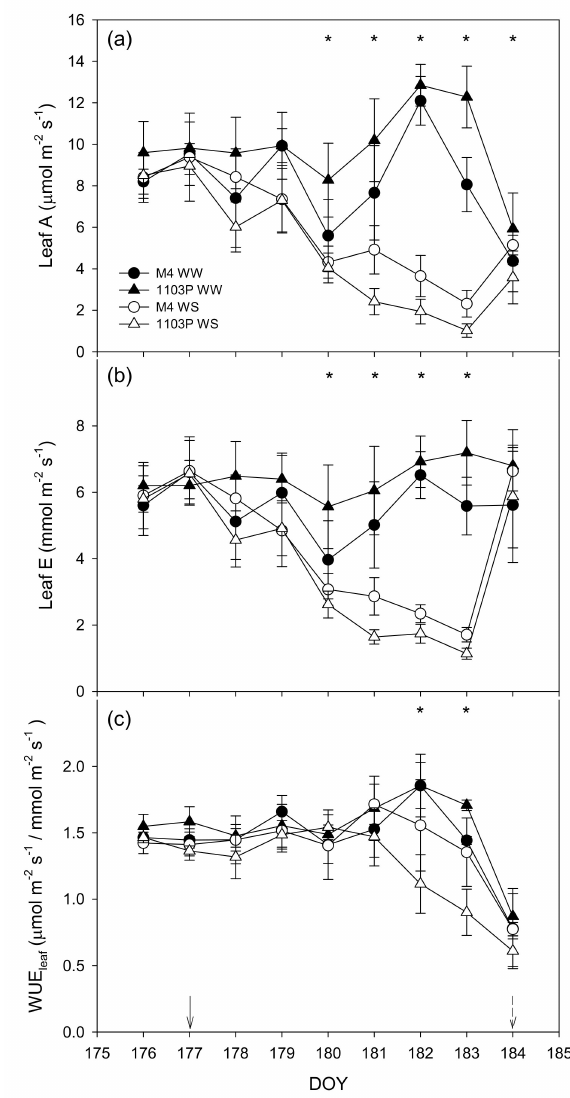
Figure 2. Trends for leaf assimilation (A, panel a ), transpiration (E, panel b ), and water use e ffi ciency (WUE leaf , panel c )ofvinescv. GrechettoGentilegraftedtoM4and1103Paulsen. M4-WW = well-watered vines grafted to M4; 1103P-WW = well-watered vines grafted to 1103 Paulsen; M4-WS = water-stressed vines grafted to M4; 1103P-WS = water-stressed vines grafted to 1103 Paulsen; DOY = day of the year. Bars represent standard errors ( n = 5). Asterisk indicates dates within which significant di ff erences among treatments were found according to the SNK test ( p < 0.05). Solid arrow indicates date of imposition of WS; dashed arrow indicates date of